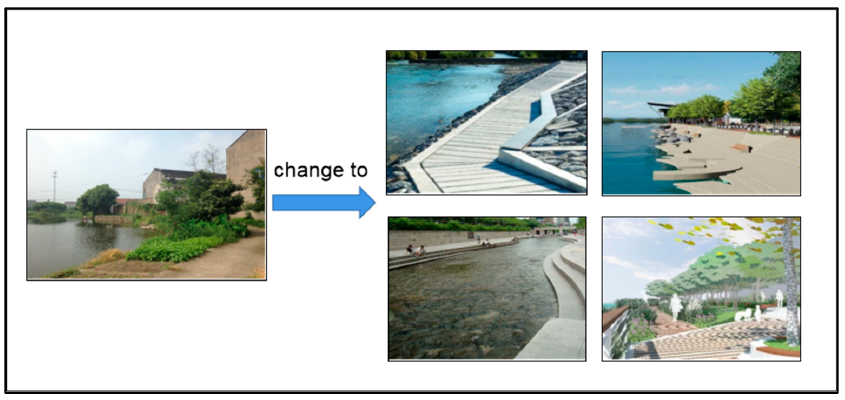
Figure 8. Design of waterfront in Pu’an village.